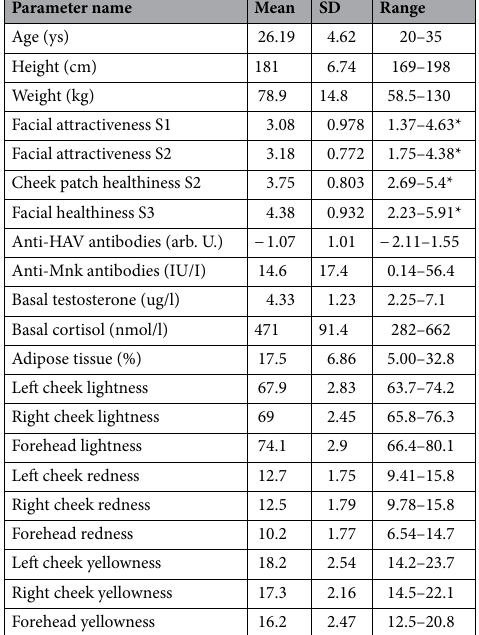
Table 1. Descriptive statistics for target’s age, height and weight, ratings of facial photographs and skin patches before vaccination, specific antibodies (difference between states 30 days after and before vaccination), testosterone and cortisol basal levels, the amount of adipose tissue, and facial skin colour (L*a*b* for cheeks and forehead) (N = 21). Mean (SD) rating for facial photographs and skin patches was calculated as the mean from aggregated ratings for each target. Values denoted by * show the mean minimum and mean maximum ratings of photographs.